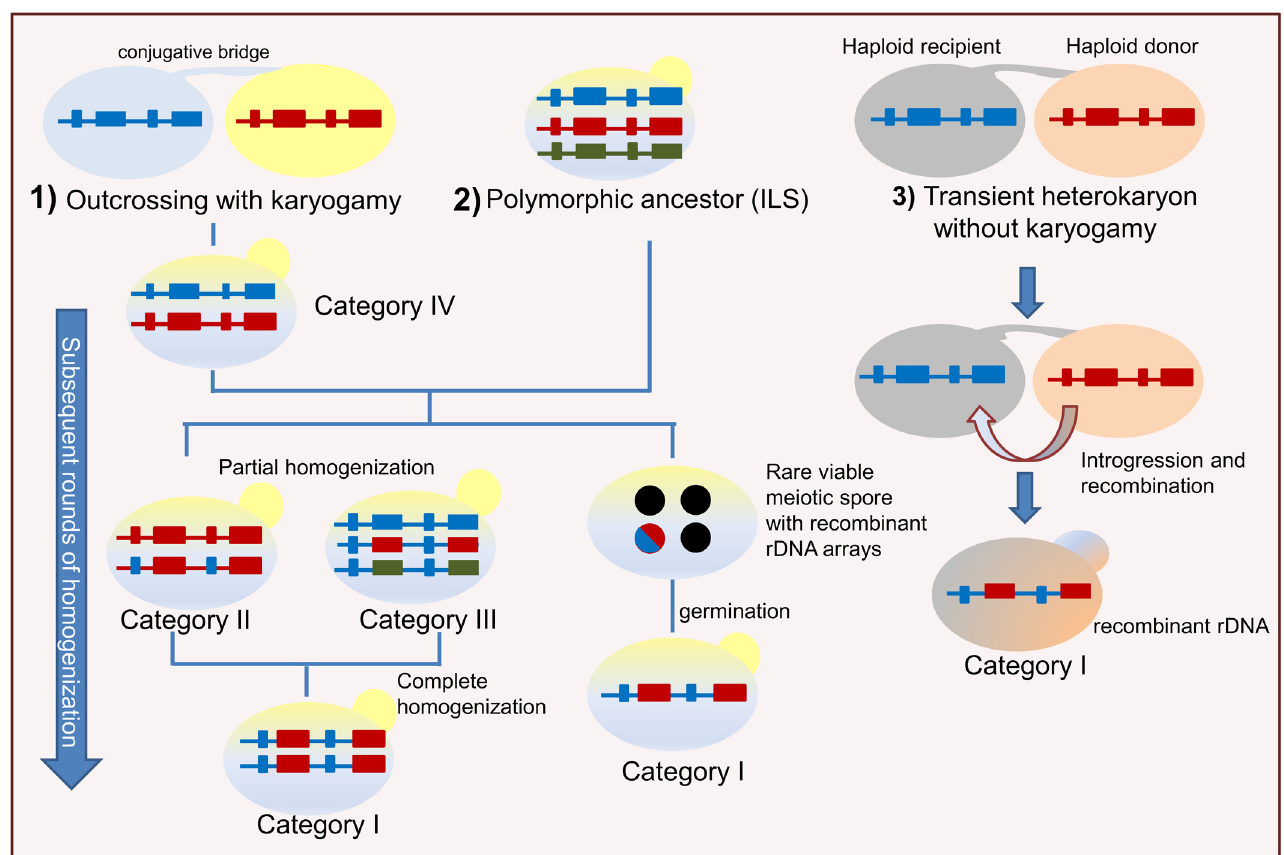
Fig 7. Model for the rDNA evolution in the Zygosaccharomyces rouxii complex. A schematic course of the evolution in rDNA arrays is shown. Small rectangles represent ITS regions, whereas the big ones 26S rRNA genes; 18S and 5.8S rRNAs are omitted for simplicity. Black circles represent unviable spores, while the blue/red circles rare viable spore. Outcrossing followed by nuclear fusion (1) or incomplete lineage sorting (2) give rise to divergent repeats in individual genomes, and set evolutionary processes in motion leading to different patterns of intra-genomic variation. A polymorphic/hybrid ancestor can rarely produce viable meiotic spores with chimeric rDNA arrays (category I). Over time some lineages partially homogenize rDNA arrays (categories II and III), whereas other descendants can retain both ribosomal variants due to low levels of homogenisation by recombination (category IV). Abbreviation: ILS: incomplete lineage sorting. Alternatively, outcrossing between two divergent haploid cells results in a transient heterokaryon (without nuclear fusion) (3) which undergoes introgression, i.e. the transfer of genetic materials from a donor to a recipient cell. The blue rDNA array and the introgressed red array donated by the pink parental cell recombine, leading to chimeric rDNAs (category I).